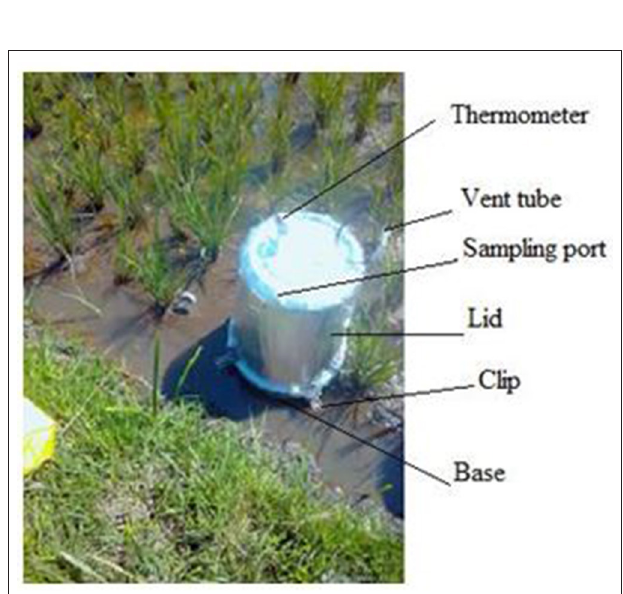
PLATE 1 | Pictorial representation of a fabricated gas